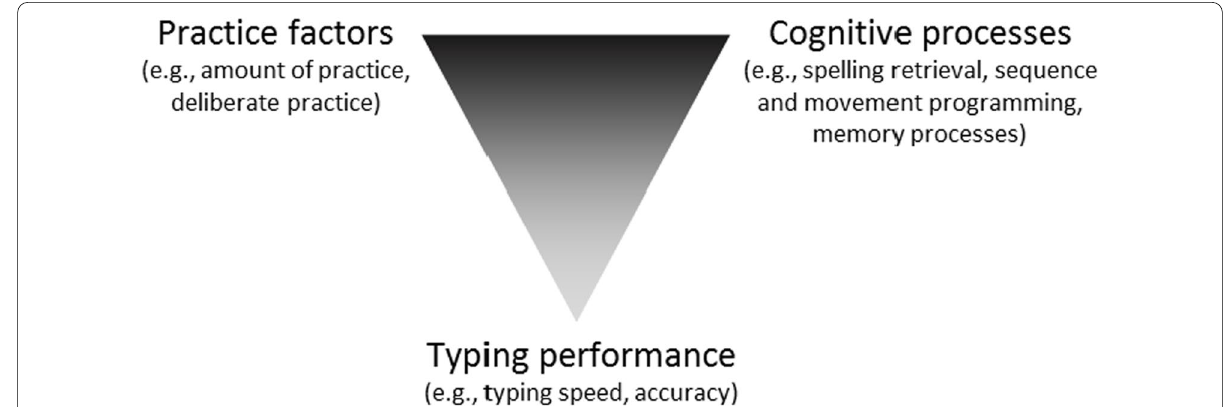
Fig. 1 Characterizing typing performance, in terms of practice factors and cognitive